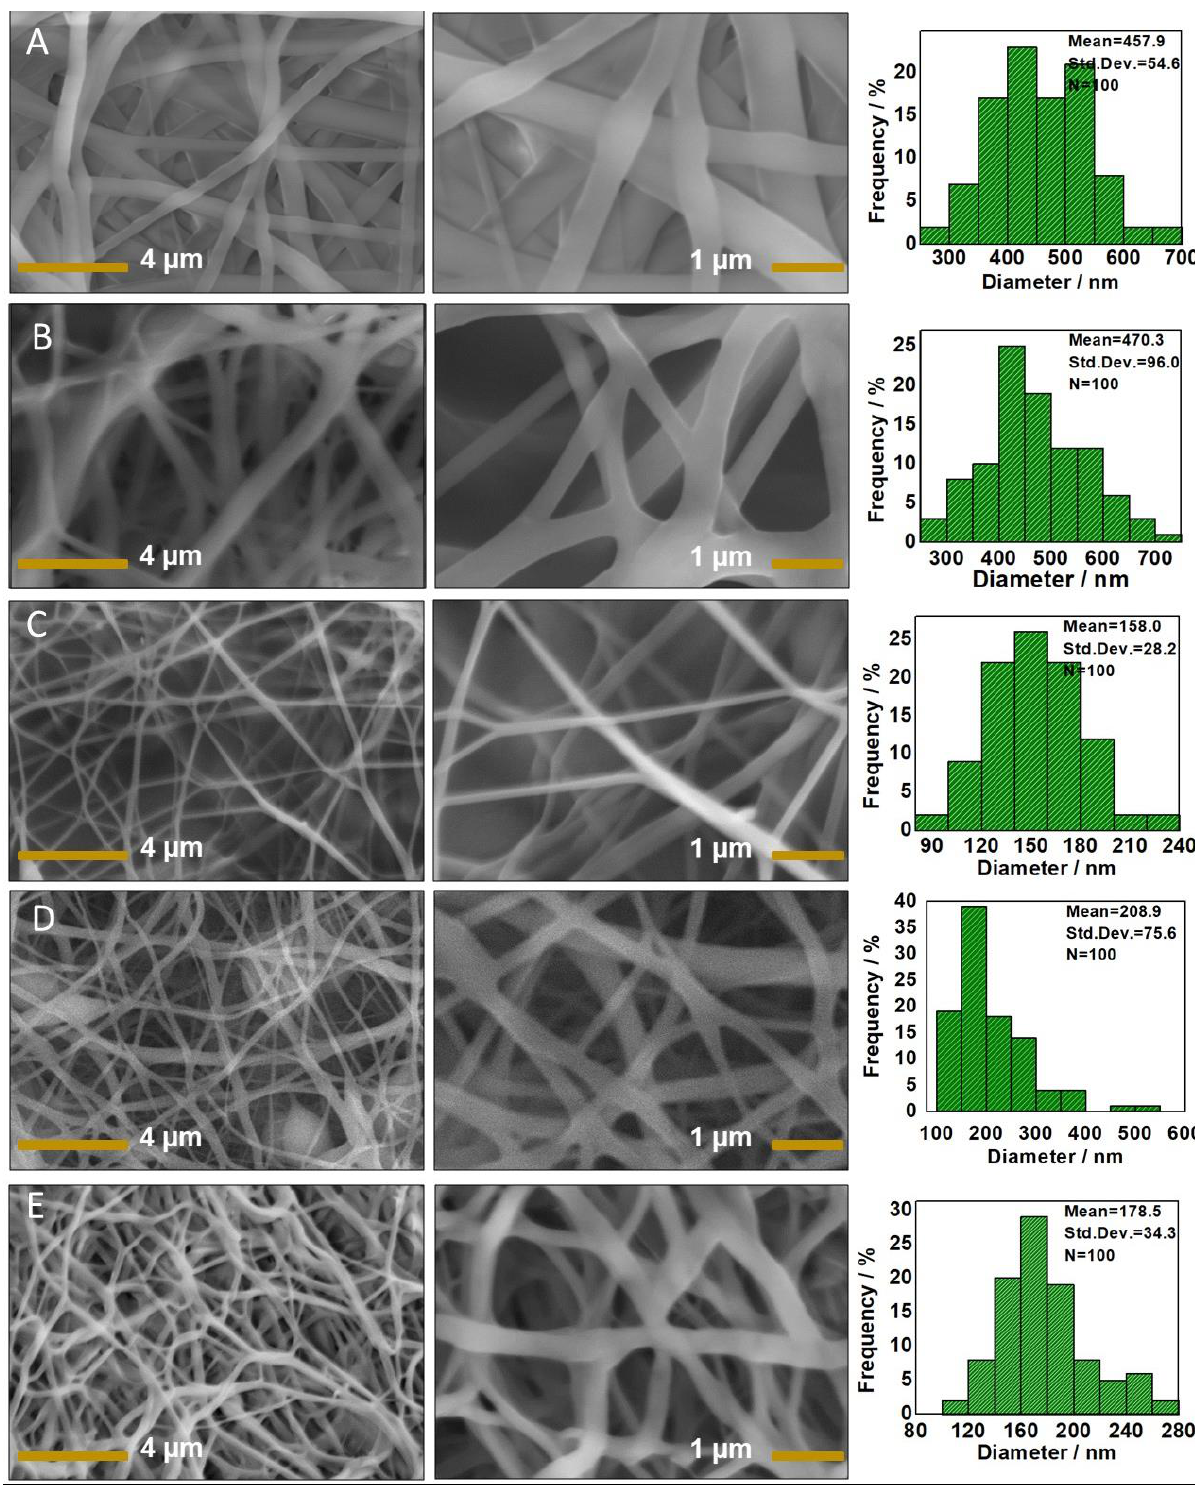
Figure 2. SEM micrographs of the developed NFs: ( A ) PU NFs; ( B ) Neat layer-by layer PU/PVA-Gel NFs (Pure-S1); ( C ) nCeO 2 NP-loaded PU/PVA-Gel NFs (nCeO 2 -S2); ( D ) CEO/nCeO 2 -loaded PU/PVA-Gel NFs (CEO/ nCeO 2 -S3); and ( E) CEO/nCeO 2 -loaded PU/PVA-Gel NFs (CEO/nCeO 2 -S4).